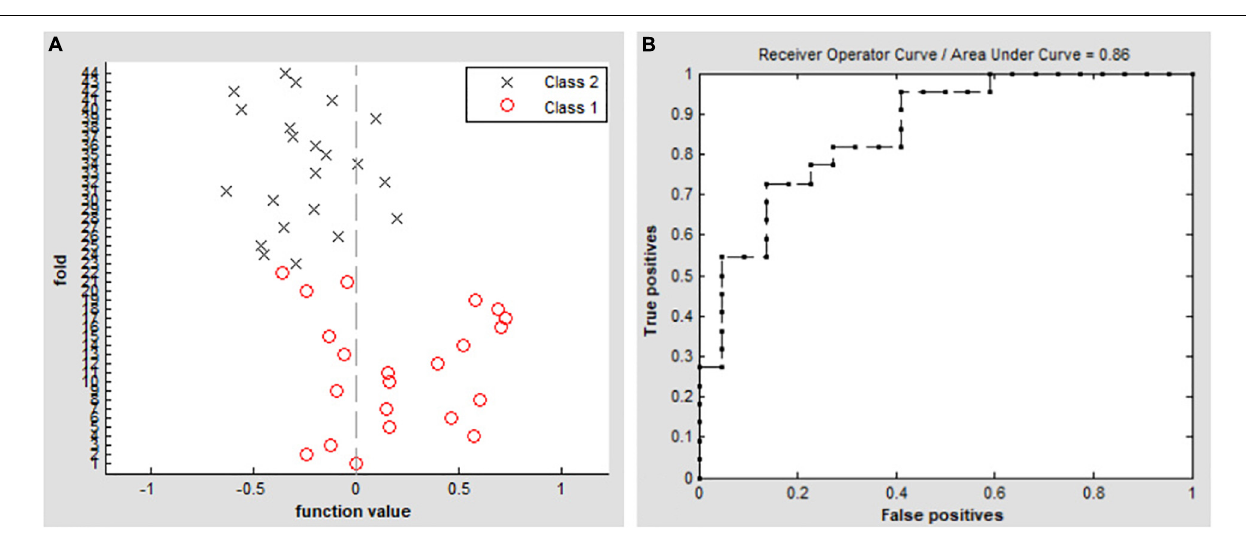
FIGURE 4 | Classification results by SVM analysis based on DC values. (A) Functional values in the two groups (class 1: EB group, class 2: SC group). (B) ROC curve of the SVM classifier with an AUC value of 0.86. DC, degree centrality; EB, early blindness; SCs, sighted controls; ROC, receiver operating characteristic; SVM, support vector machine; and AUC, area under the